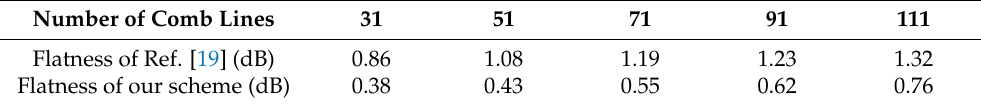
Table 1. The flatness of generated OFCs compared with Ref. [19].